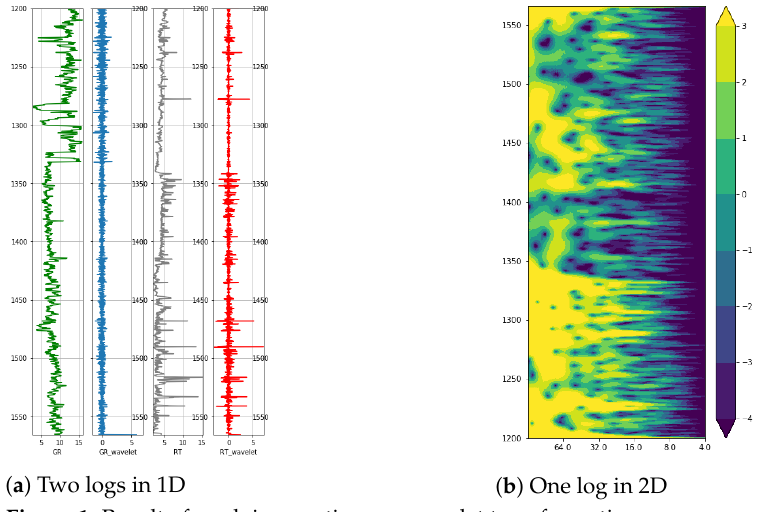
Figure 1. Result of applying continuous wavelet